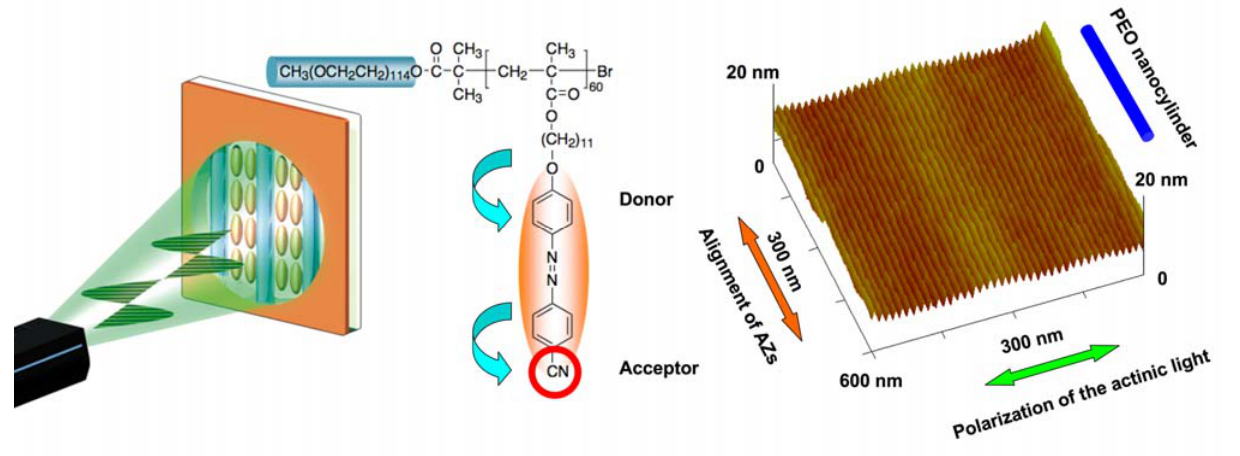
Figure 15. Photoalignment of microphase-separated nanocylinders in an LC